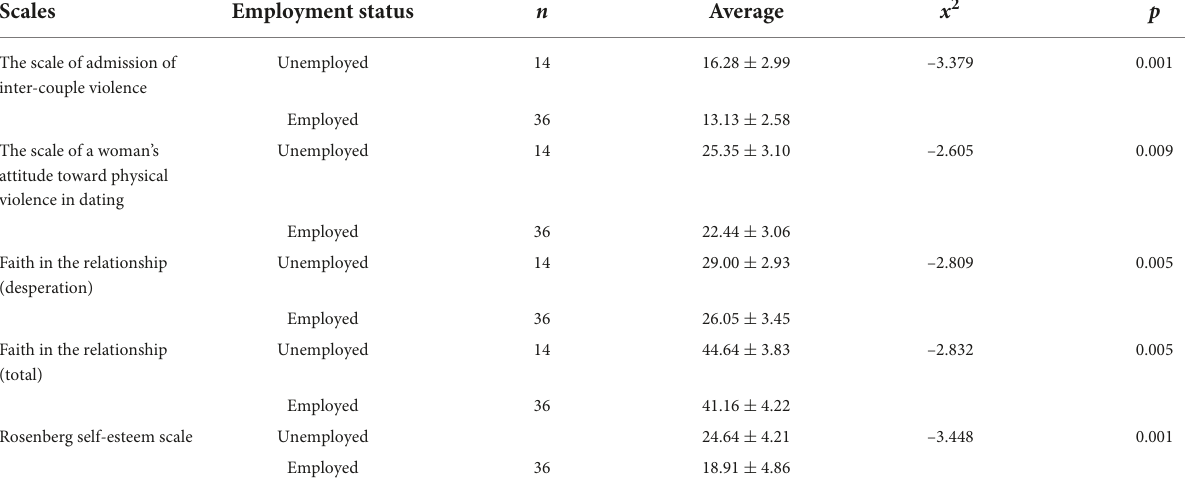
TABLE 2 Relationship between employment status and scales.